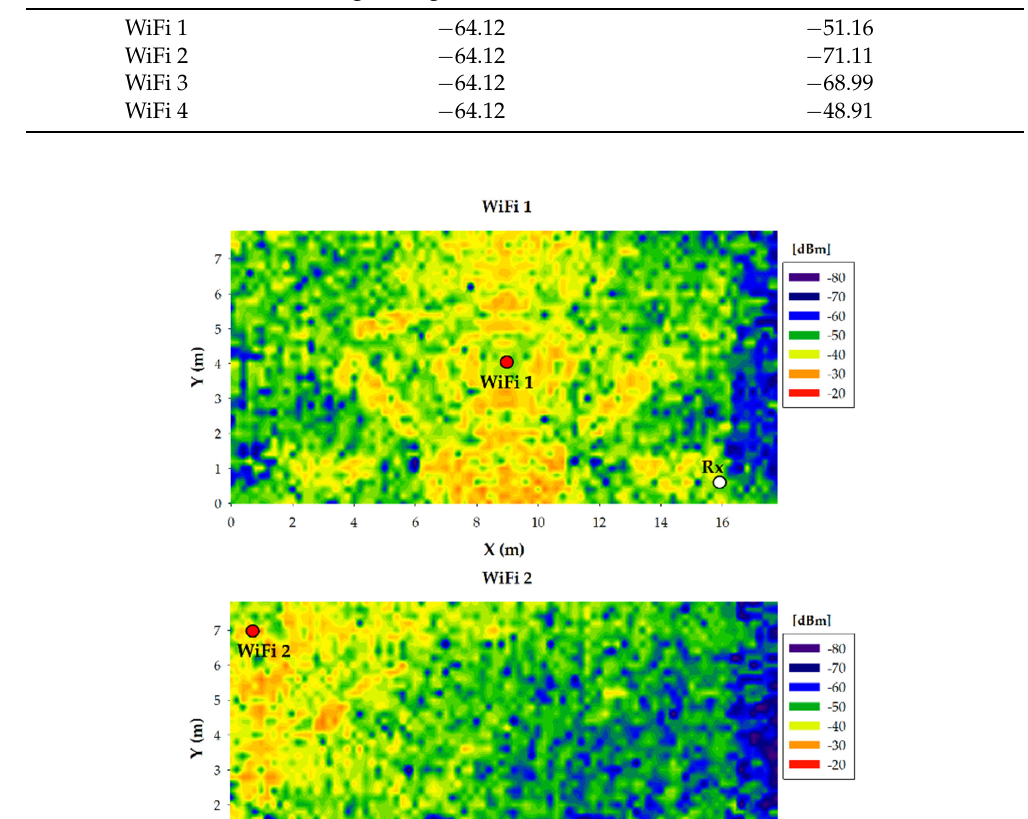
Table 3. Simulation results at receiver point (Rx) for ZigBee transmitting 10 dBm and WiFi transmitting 20 dBm.